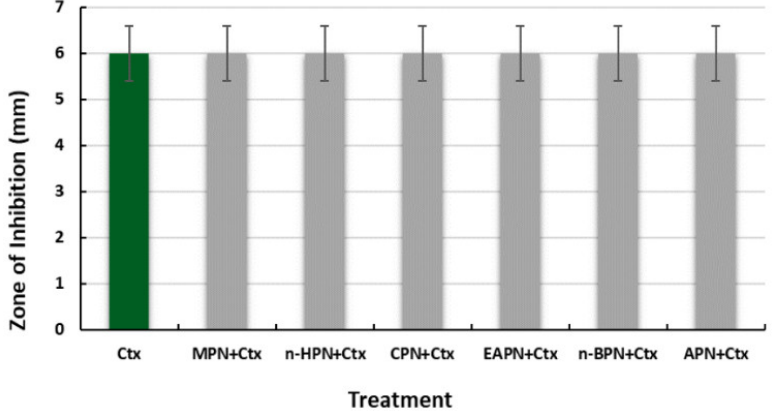
Figure 15. Antibiotic reversal activity of P. nigrum extracts in combination with cefotaxime (30 μg) for S. typhi .